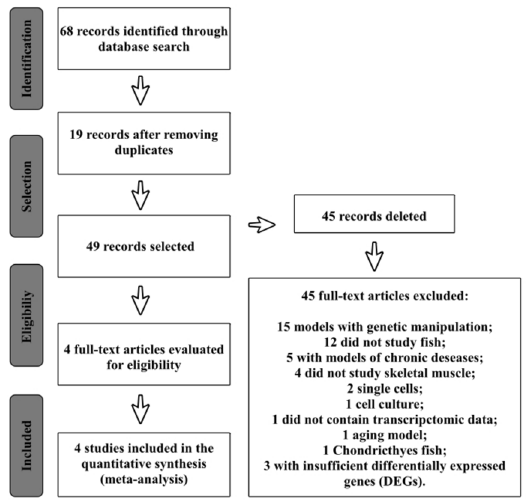
Figure 1. Literature search flowchart obtained from PRISMA in the meta ‐ analysis.